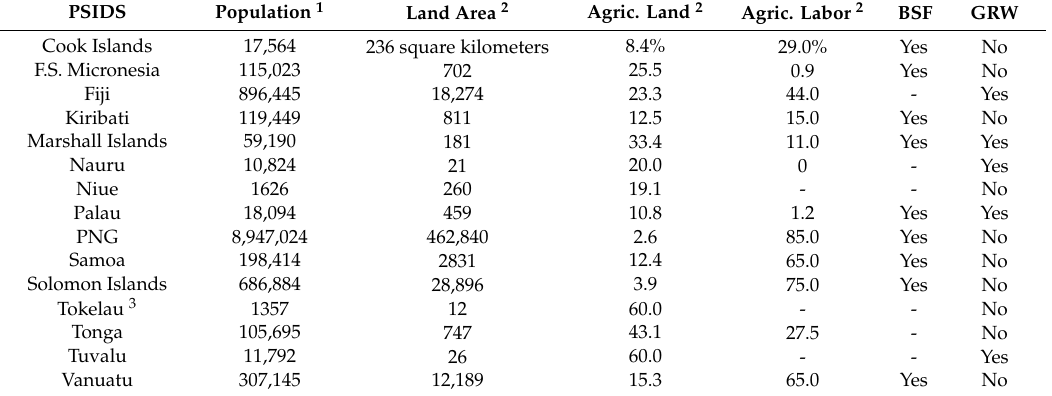
Table 1. Summary of the Pacific Small Island Developing States (PSIDS), the percentage of the land and labor force involved in agriculture, and whether or not they have black soldier fly (BSF) or municipal green-waste recycling (GRW)